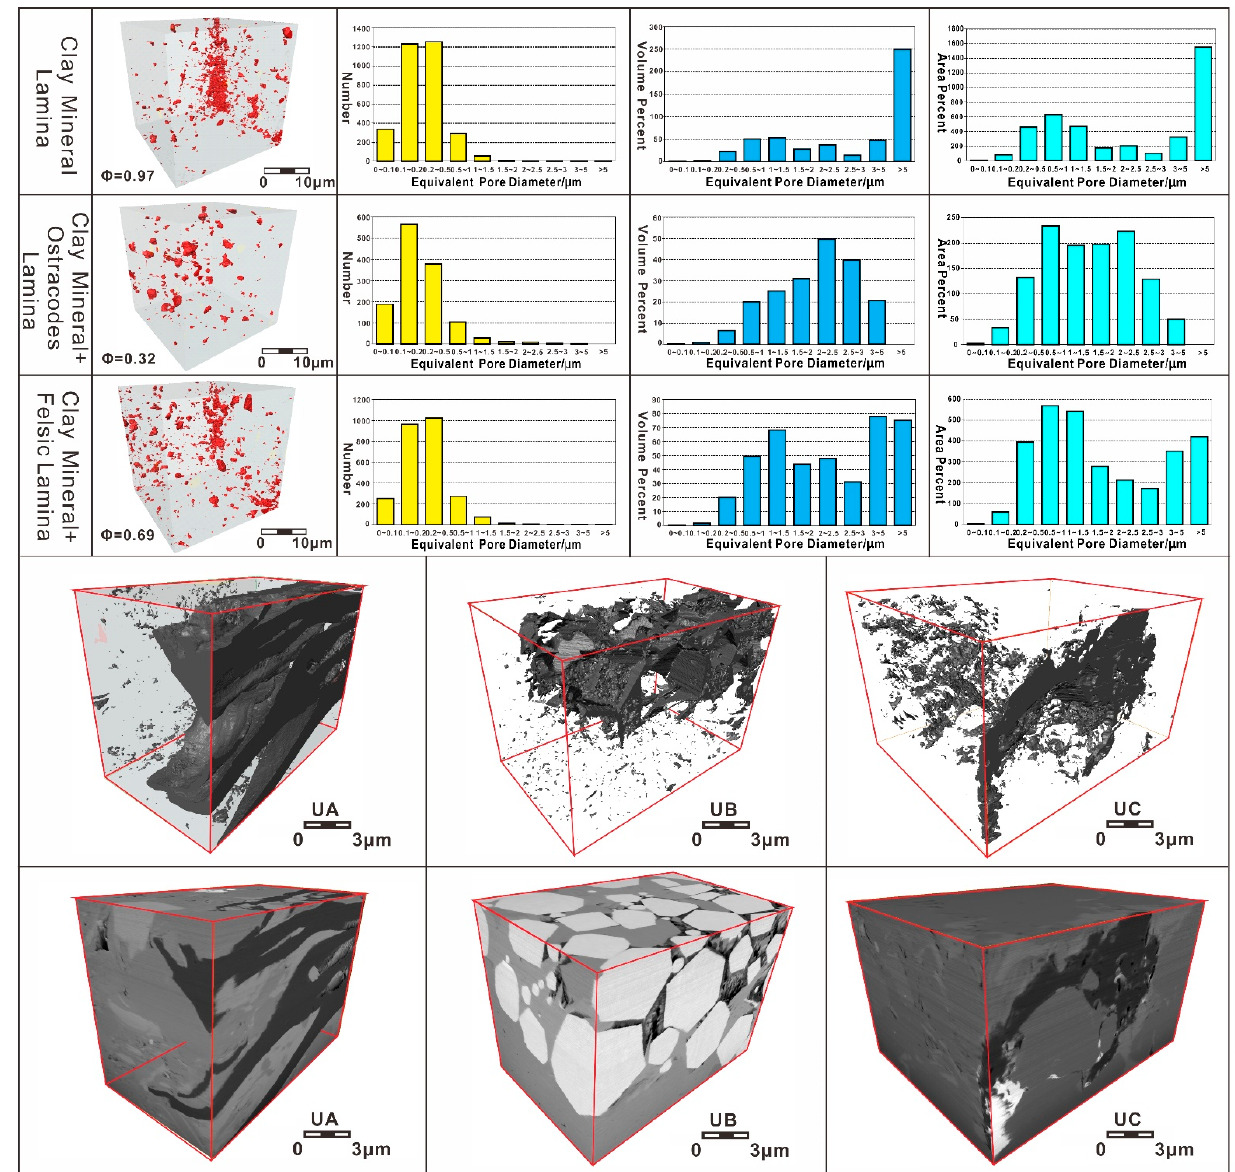
Figure 7. 3D pore characterization of different laminar